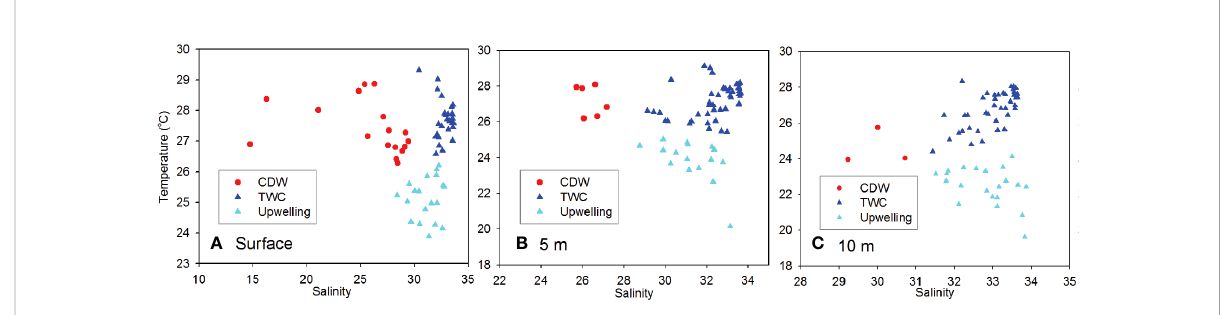
FIGURE 6 Temperature-salinity scatter plots at (A) surface, (B) 5-m and (C) 10-m layers off the CE in August